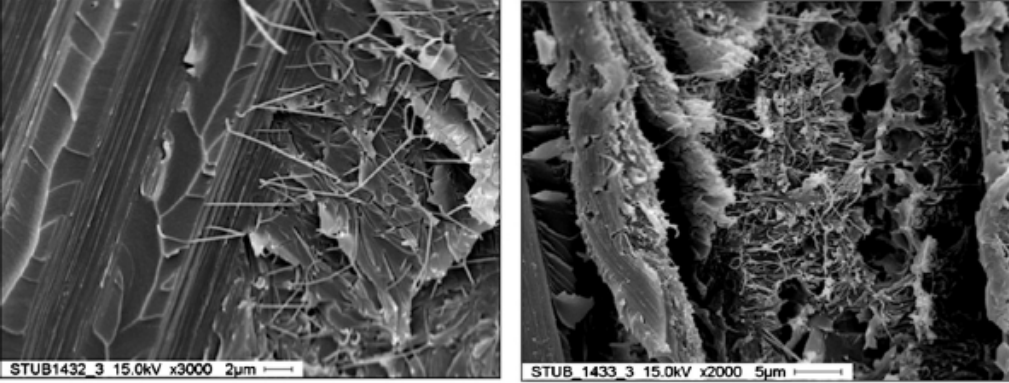
Figure 4. Toughening mechanism by NY66 [27] .